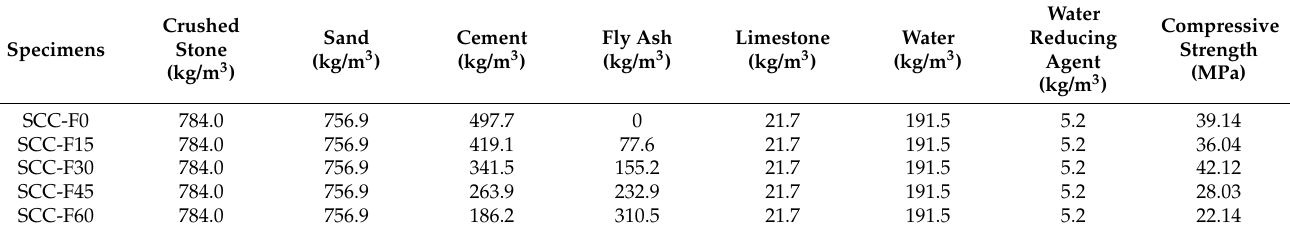
Table 2. Mix proportions for the test SCC